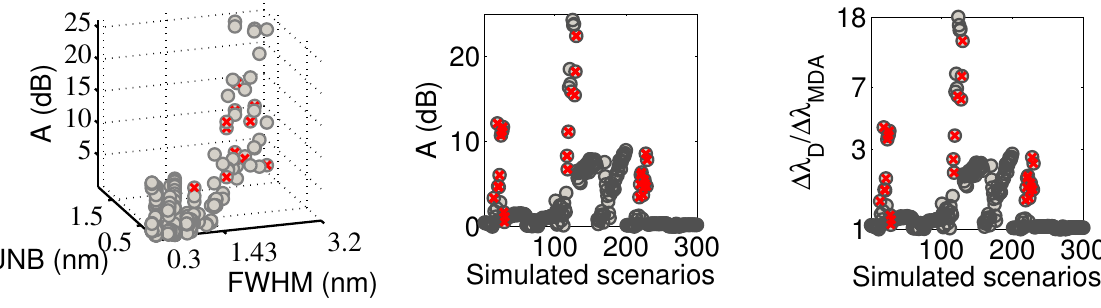
Figure 6. Accuracy of the CD algorithm as a function of the indices FWHM and UNB ( left ) and simulated scenarios ( center ). The ratio ∆ λ D scenarios ( right